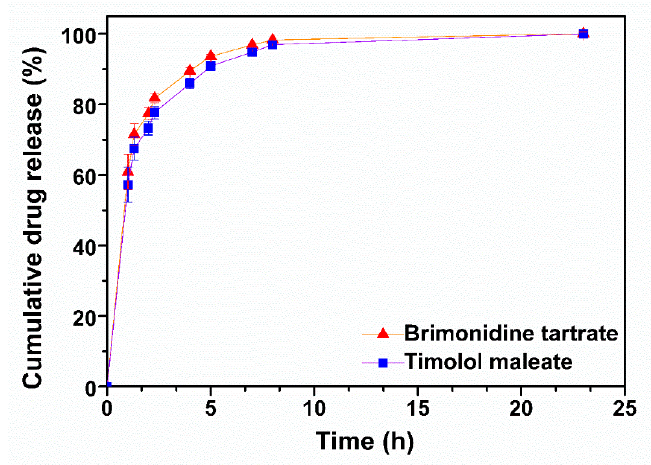
Figure 3. In vitroreleaseprofilesofbrimonidinetartrateandtimololmaleatefromtheac-(RADA) 4 -CONH 2 Figure 3. In vitro release profiles of brimonidine tartrate and timolol maleate from the ac-(RADA) 4 - peptide hydrogel in STF pH 7.4 at 37 ◦ C ( n = CONH 2 peptide hydrogel in STF pH 7.4 at 37 °C ( n = 4).